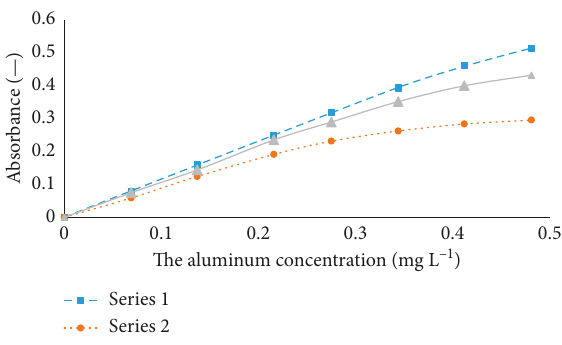
Figure 8: Dependence between absorbance and aluminum